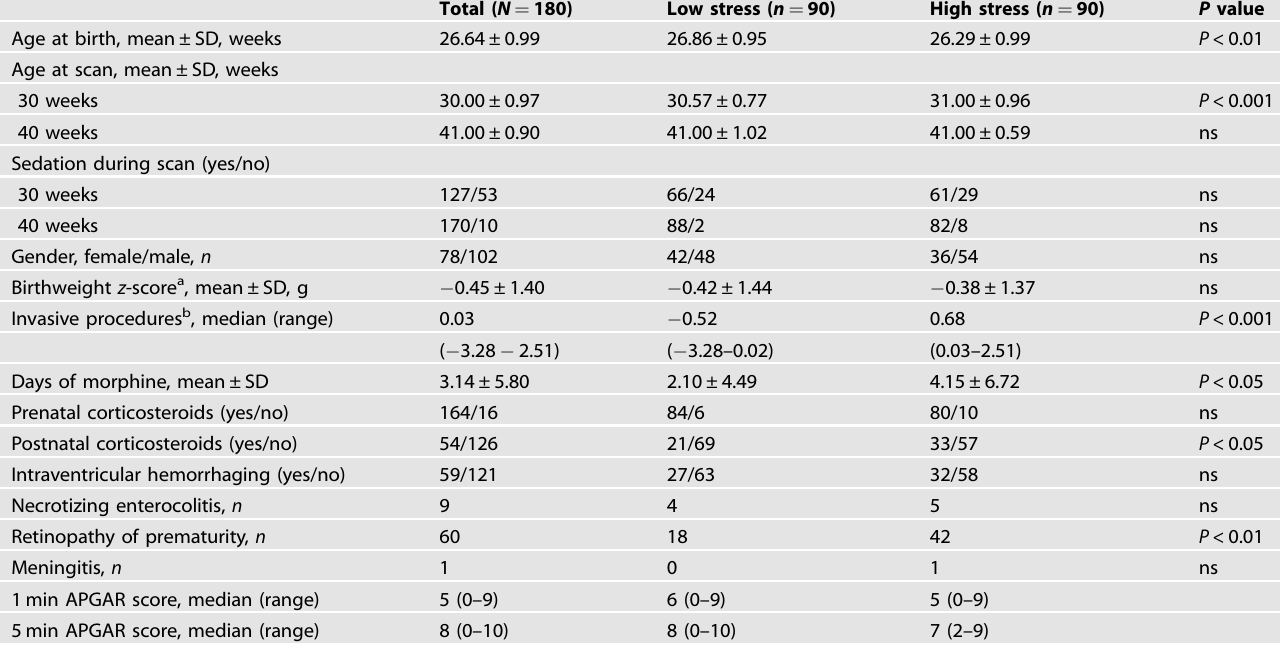
Table 1. Sample demographic and neonatal clinical details ( n =